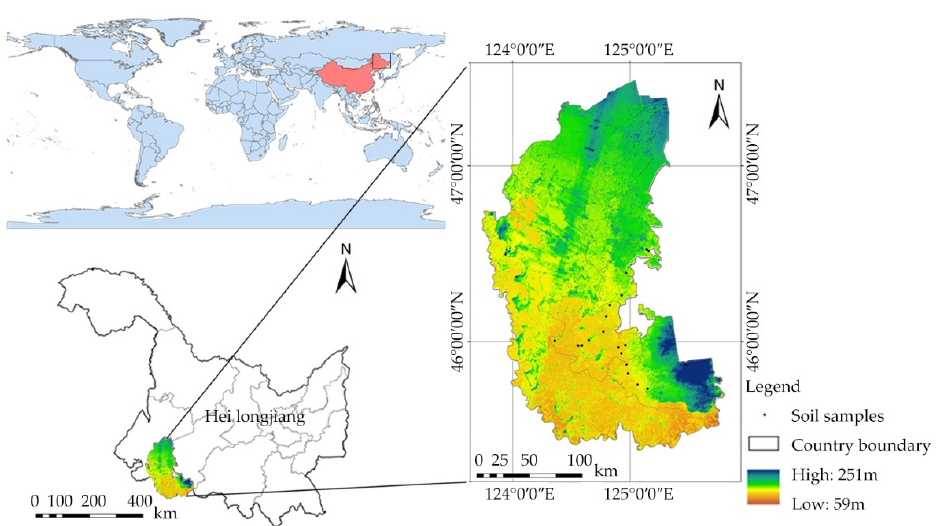
Figure 1. Distribution area diagram of the soil sampling area.